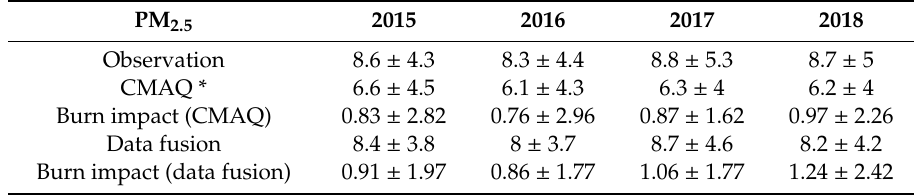
Table 1. Means and standard deviations ( µ g / m 3 ) of the total particulate matter with an aerodynamic diameter less than 2.5 µ m (PM 2.5 ) concentrations and burn impacts at monitoring sites during the prescribed burning seasons (January–April) of 2015–2018.